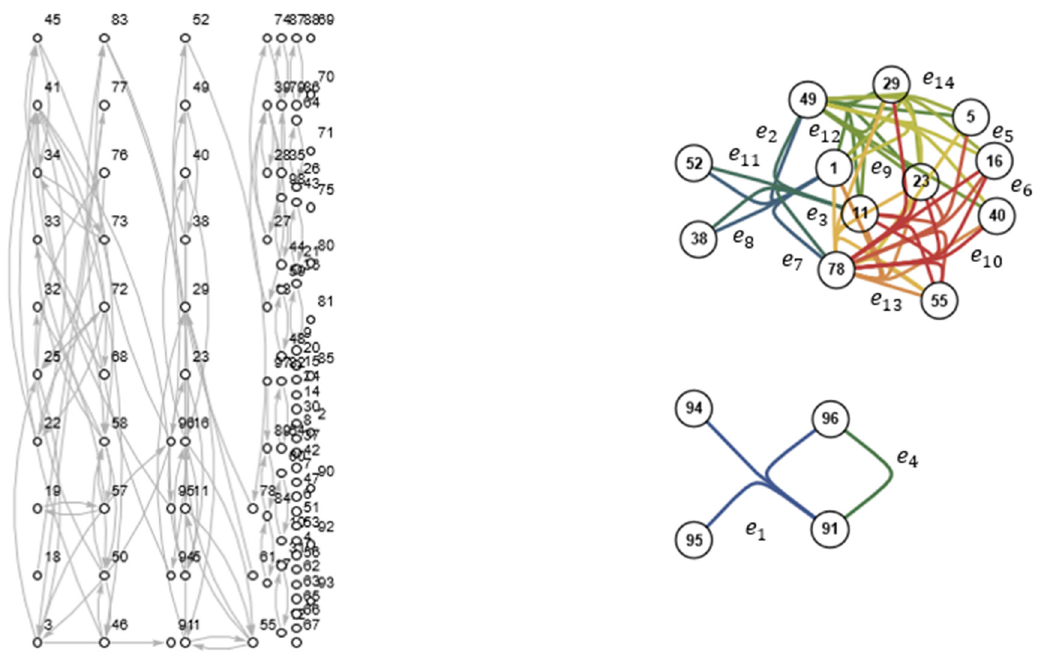
Figure 4. Directed network (on the left) and a network soft set (on the right) representation for the 2018 pre-stress economic period. Note: Numbers denote company indices (see Tables A1 and A2) and E = { e 1 , e 2 , . . . , e 14 } is the soft parameter set.